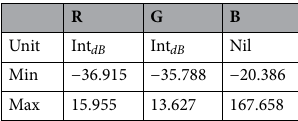
0 values in different